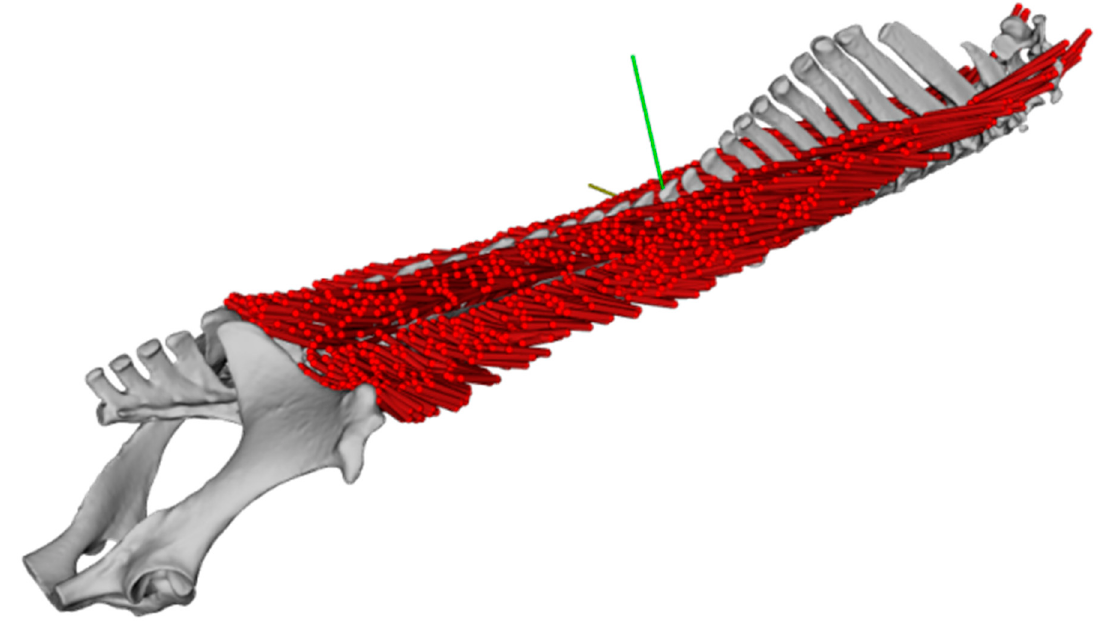
Figure 10. The model of the longissimus dorsi muscle based on the fibre digitalisation of the study. The model was used to simulate muscle activity within OpenSim software.